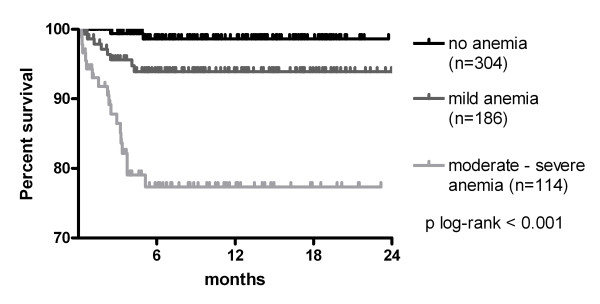
Kaplan-Meier survival curve for ART-naïve HIV-infected patients with no (black), mild (dark grey) or moderate/severe anemia (light grey) (n = 604).